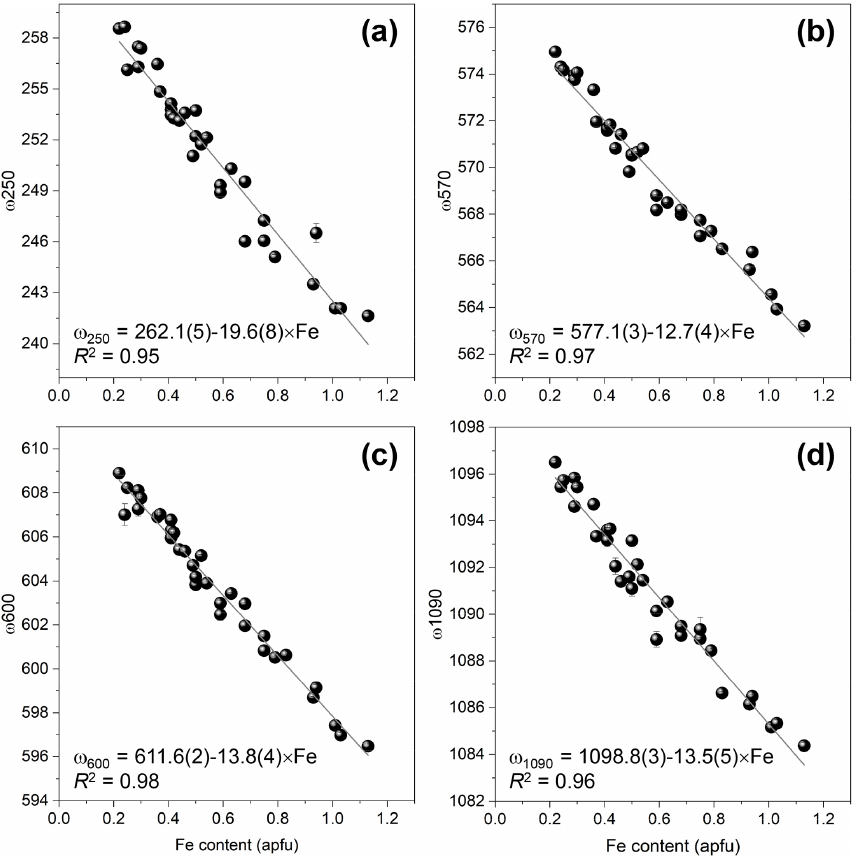
Figure 8. The correlations between Fe content (apfu) and frequencies of ω 250 (a) , ω 570 (b) , ω 600 (c) , and ω 1090 (d) determined the data listed in Table